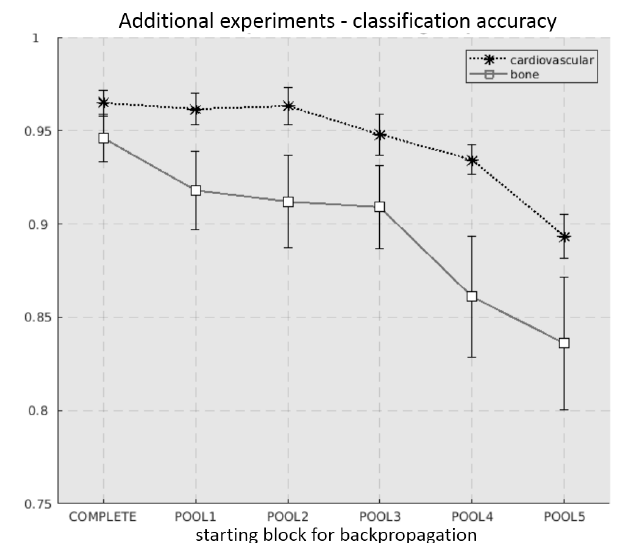
Figure 10. Patch scores of a fine-tuned VGG-16 network on the cardiovascular and bone datasets, at different extensions of the fine-tuning. The markers show the average accuracy values, while the bars extend from the minimum to the maximum accuracy values on each individual